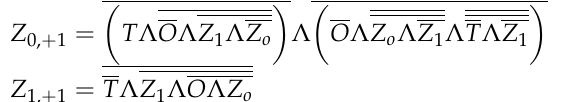
Figure 15. Simulated waveforms of the state machine with quench timer connected for a random input bit pattern (top, blue) at 1 Mbps.